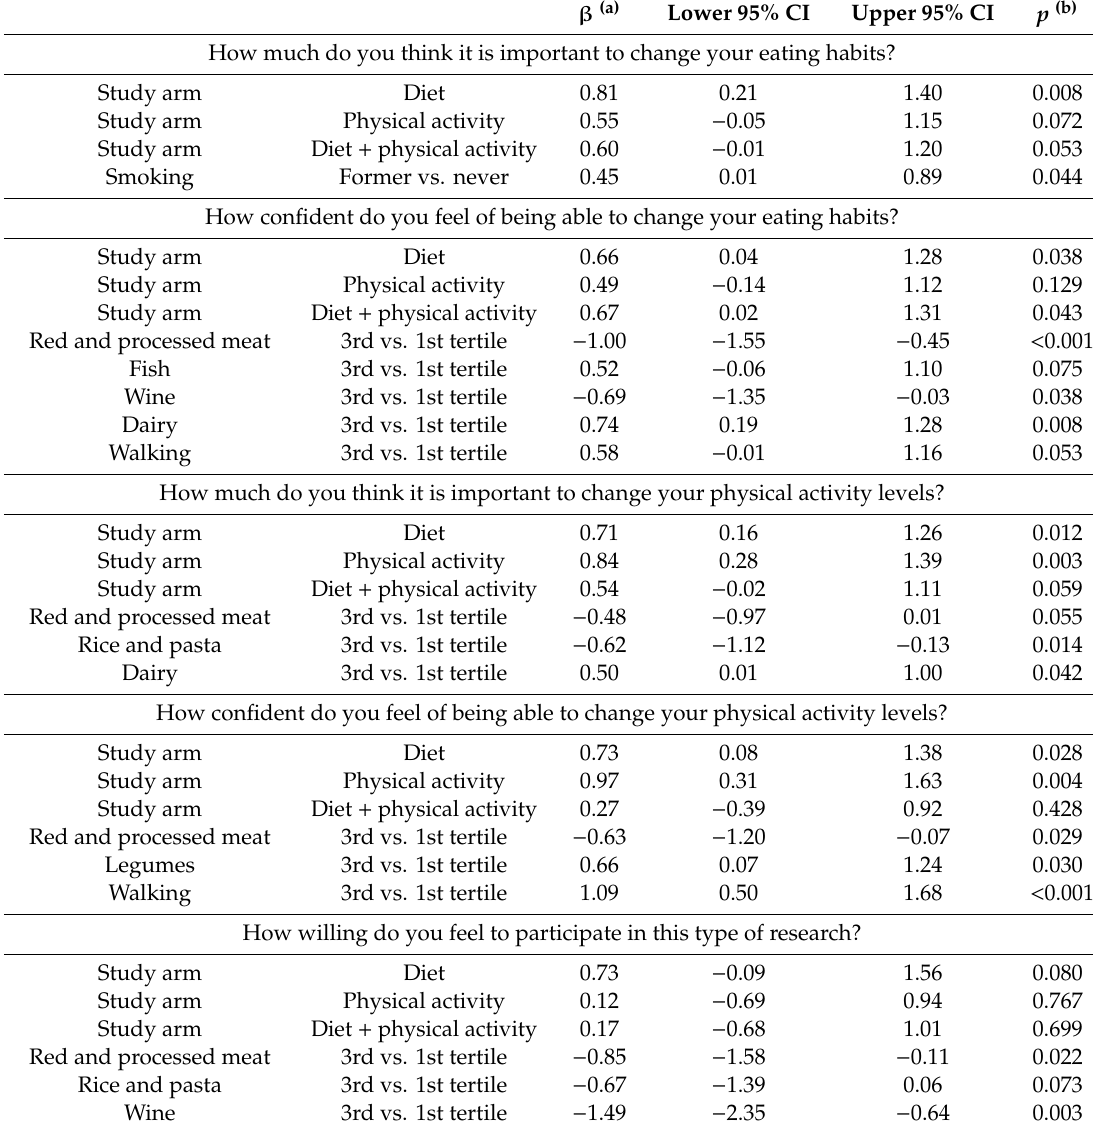
Table 2. Factors associated with the change in motivation between baseline and end-of-study questionnaires. The diet, physical activity and mammography trial. Florence, Italy,